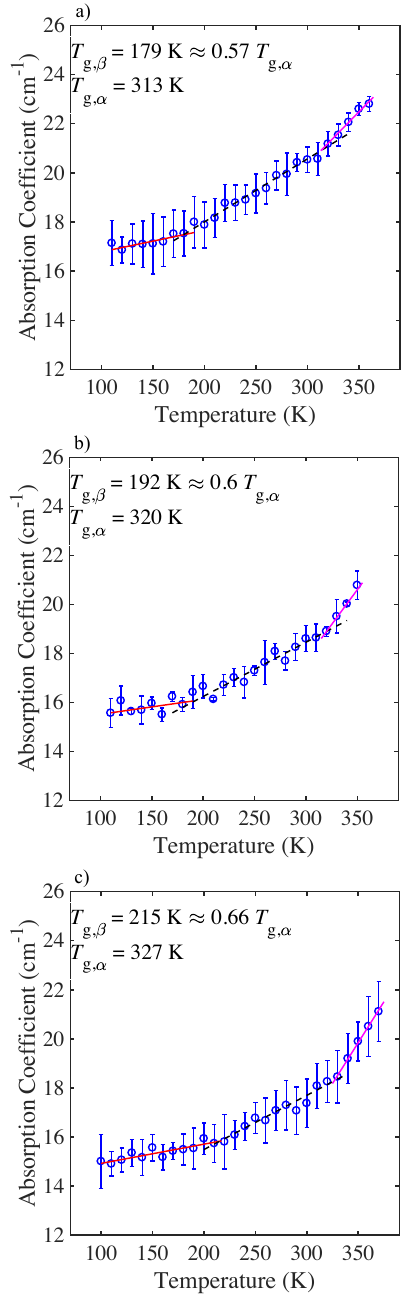
Figure 5. Mean terahertz absorption coefficient as a function of temperature at 1 THz for PLGA 75:25 microspheres. Error bars represent the standard deviation for n samples ( a ) blank ( n = 3), ( b ) low ( n = 3), and ( c ) high peptide loading ( n = 3). Lines show the different linear fits for the different